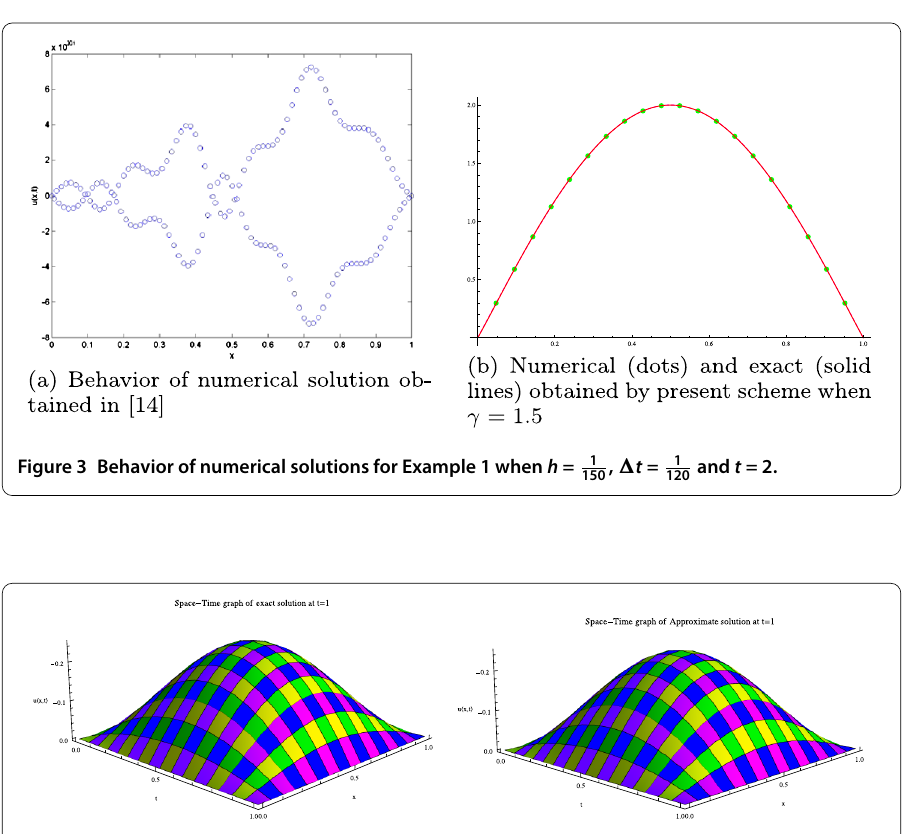
Figure 4 A 3D comparison of exact (left) and numerical solutions (right) for Example 1 when h = 1 (cid:2) t = 1 and γ = 1.5 at t = 100